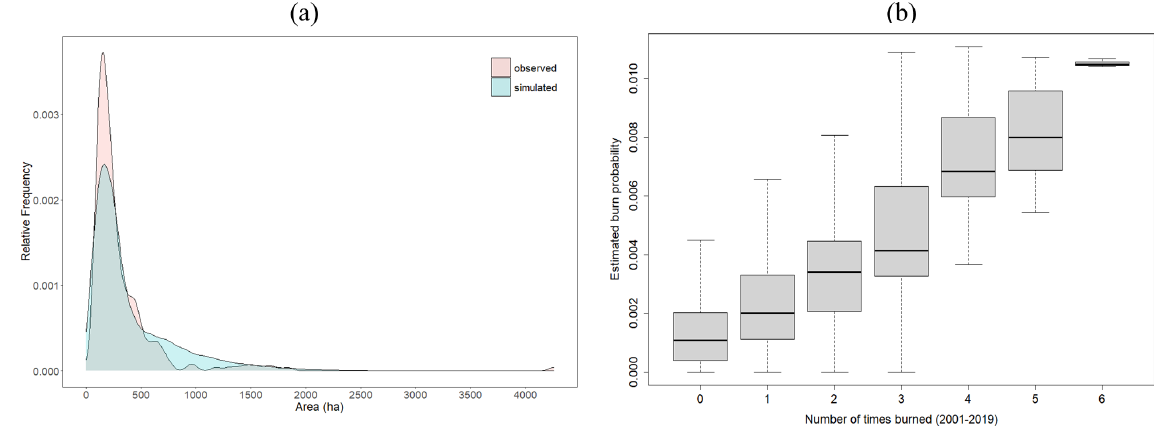
Figure E1. Comparison (a) between the simulated and observed burned area and (b) between the estimated burn probability and the historical frequency of burning.